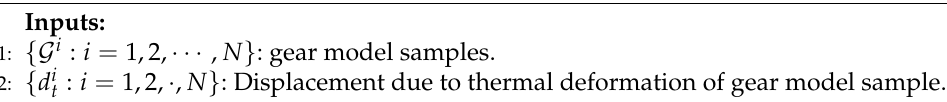
Algorithm 2 Gear pair sampling.